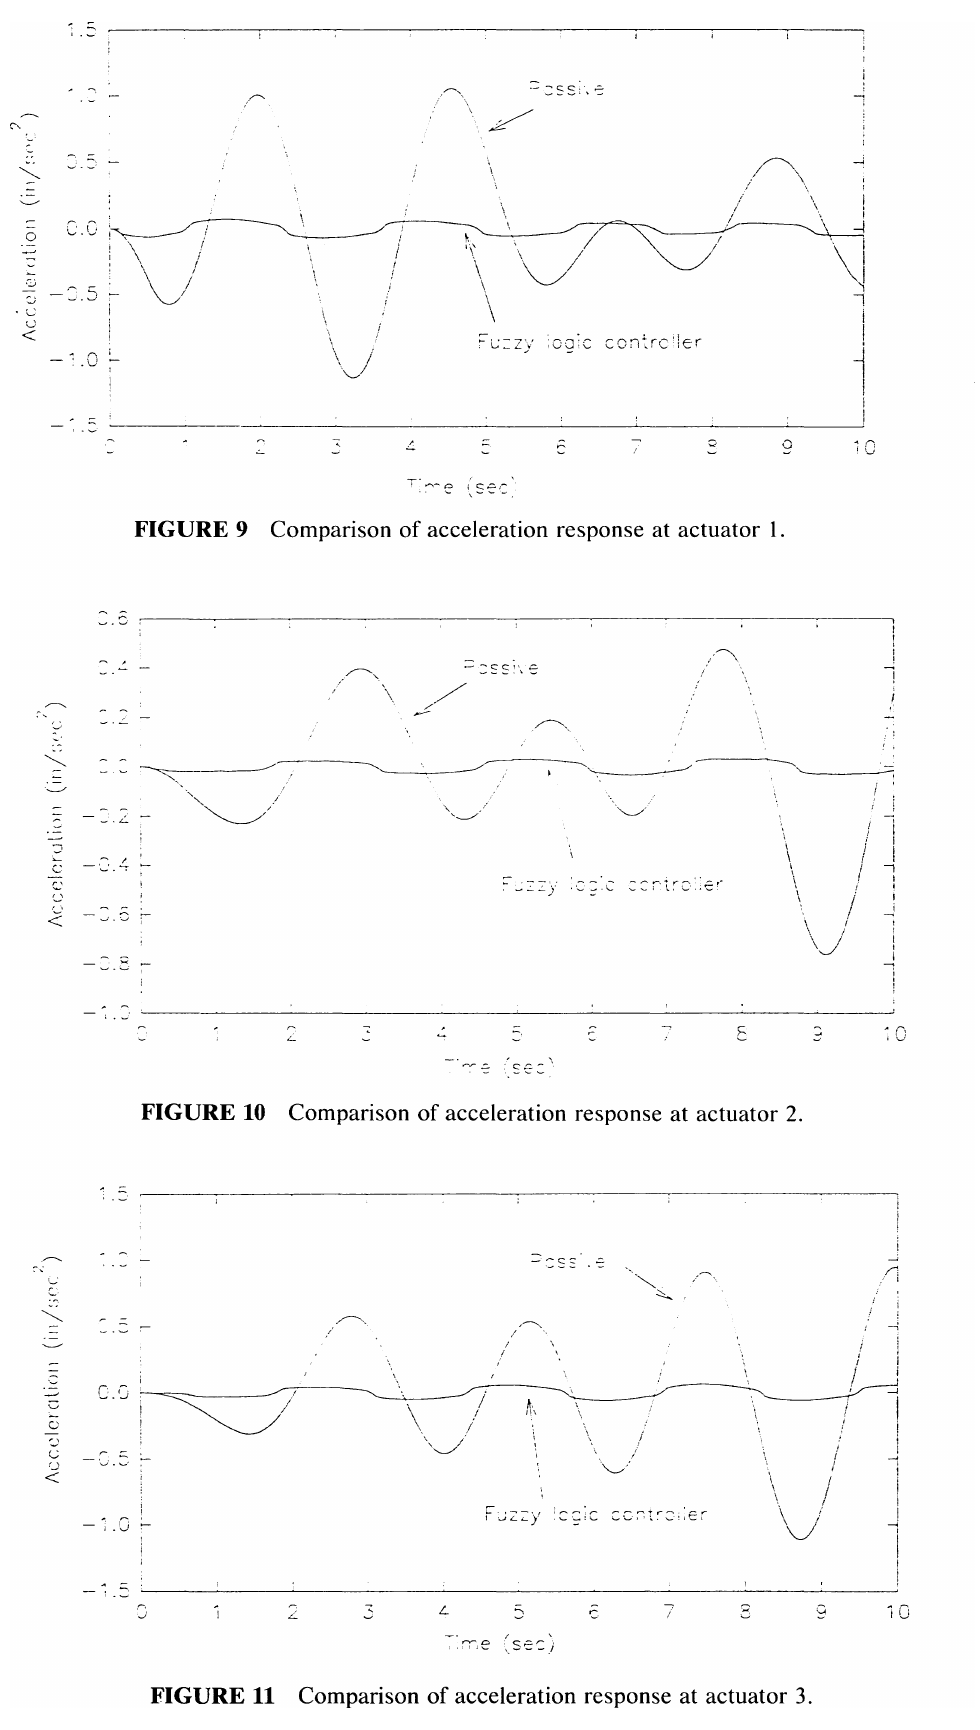
FIGURE 11 Comparison of acceleration response at actuator